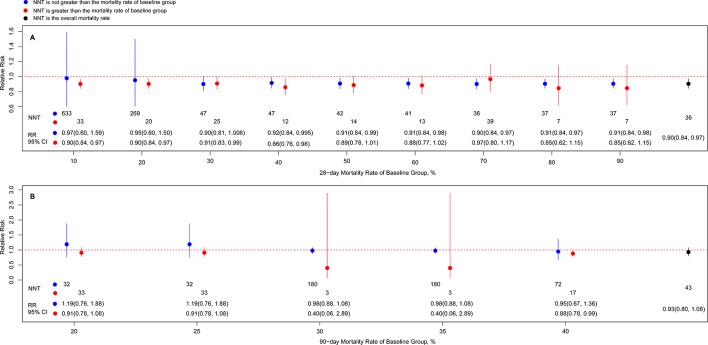
Associations of risk ratio of death at day 28 (A)/day 90 (B) of long course of low-dose corticosteroids and different cutoff of baseline mortality. Note: Blue node and line indicates the risk ratio (RR) with 95% CI from subgroup based on not greater than the mortality rate of baseline group, and the lower value corresponds to the number needed to treat value; red node and line indicates the RR with 95% CI from subgroup based on greater than the mortality rate of baseline group, and the lower value corresponds to the number needed to treat value; black node and line indicates the RR with 95% CI from overall mortality rate, and the lower value corresponds to the number needed to treat value.